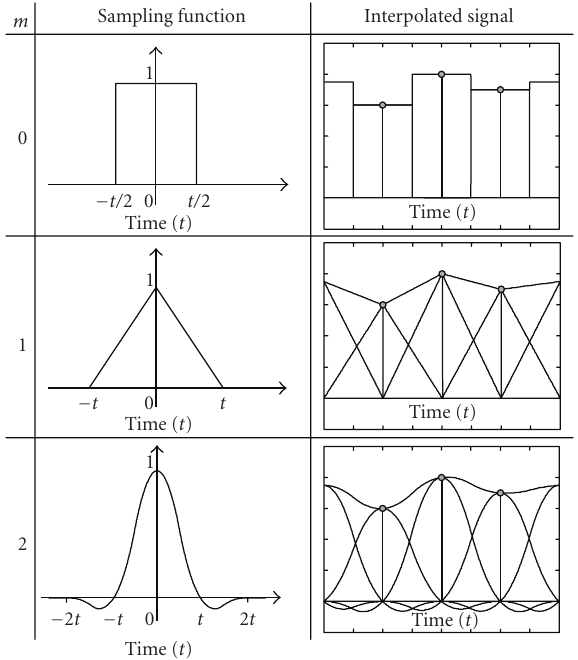
Figure 3: Sampling functions Ψ and their interpolations ( m = 1,2,3) ( τ : sampling